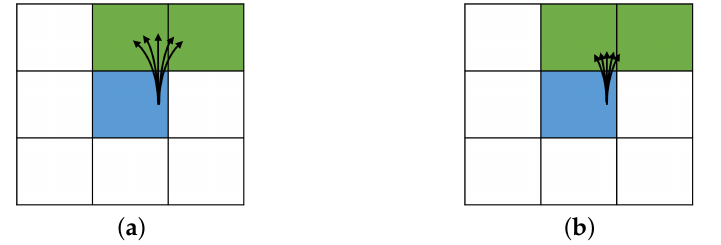
Figure 6. Smallest continuous motions in discrete domain. ( a ) Long motion primitive. ( b ) Short motion